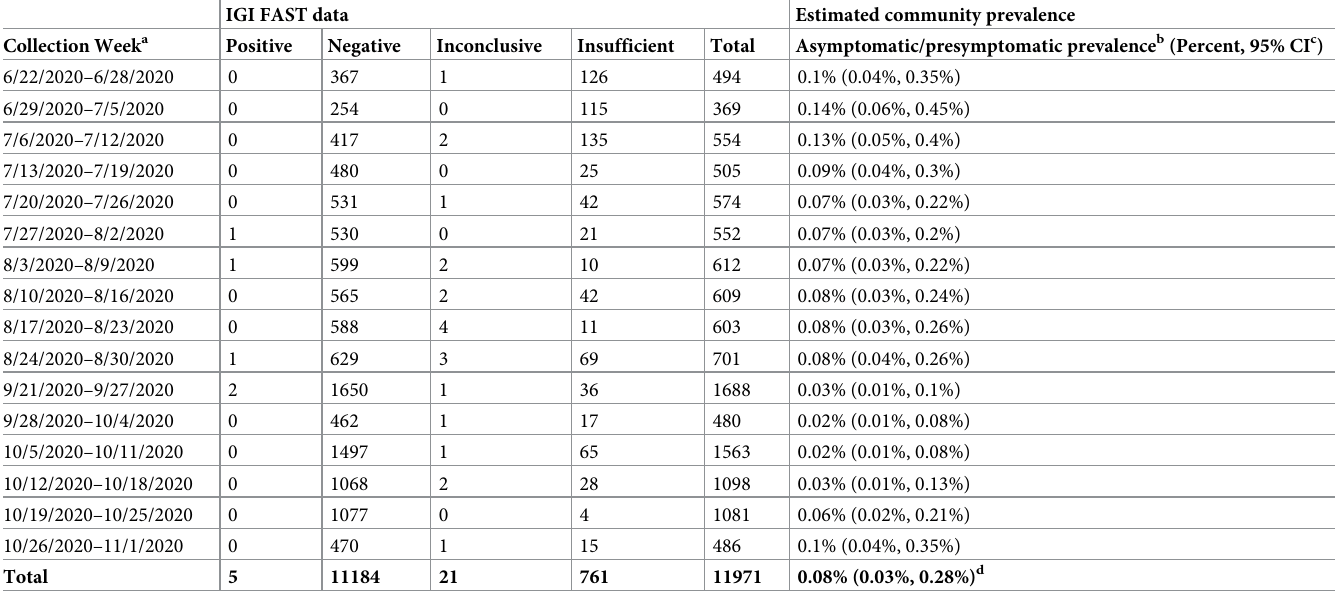
Table 4. Results and estimated community asymptomatic and presymptomatic prevalence by week. IGI FAST